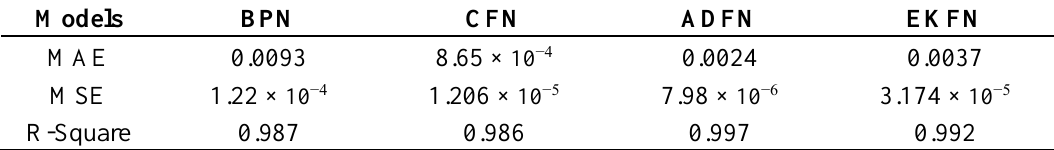
Table 1. Performance analysis for simulation de-noise using NN